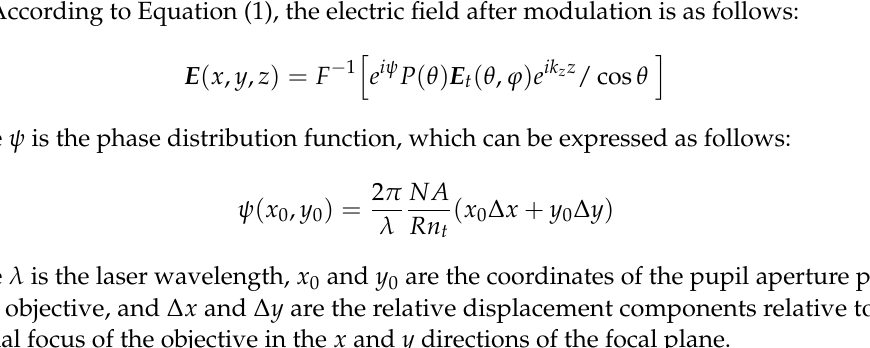
Figure 2. Schematic of the focused beam after passing through the objective. Here, 𝜑 is the azimuthal angle of the objective, 𝑟 is polar coordinate, 𝜃 is convergence angle of the objective, 𝑅 angle of the objective, r is polar coordinate, θ is convergence angle of the objective, R is the maximum is the maximum radius of the pupil plane, and 𝜃 𝑚 is the maximum convergence angle of the radius of the pupil plane, and θ m is the maximum convergence angle of the objective.